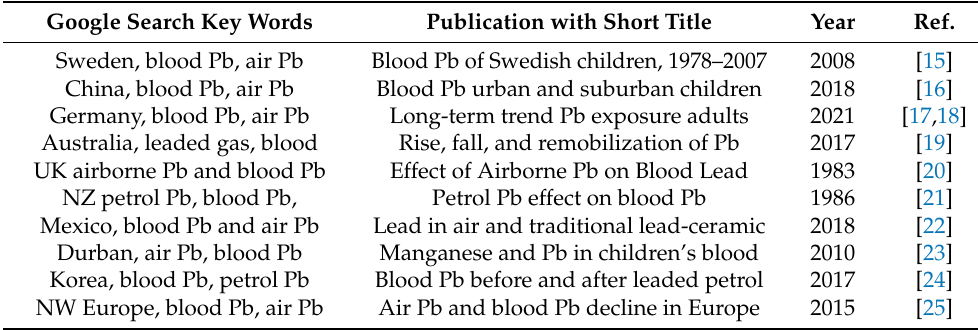
Table 1. Search results of selected countries obtained for air Pb and blood Pb.